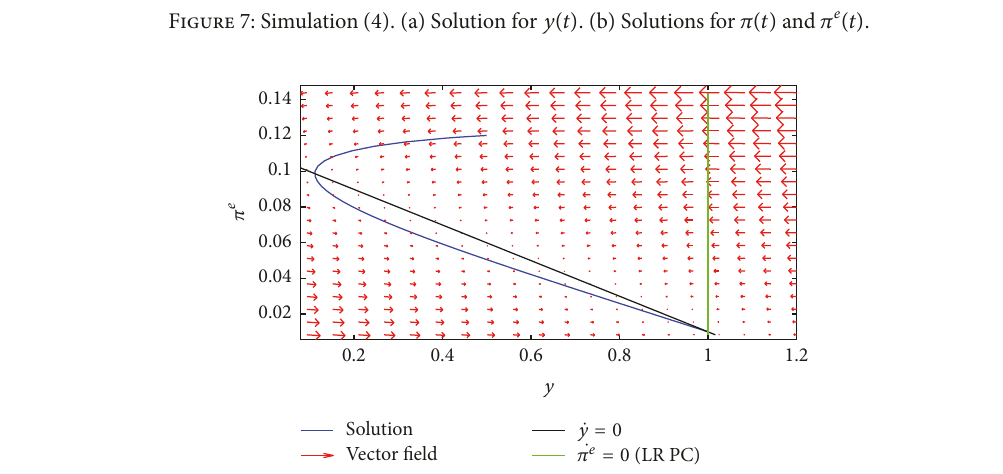
Figure 8: Simulation (4) . Phase diagram illustrates a stable